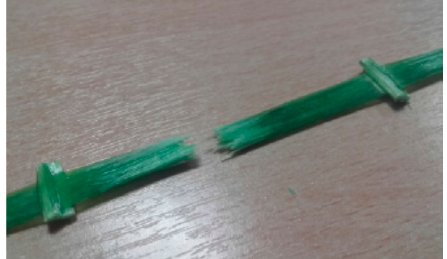
Figure 9. Catastrophic collapse of the GFRP sample.